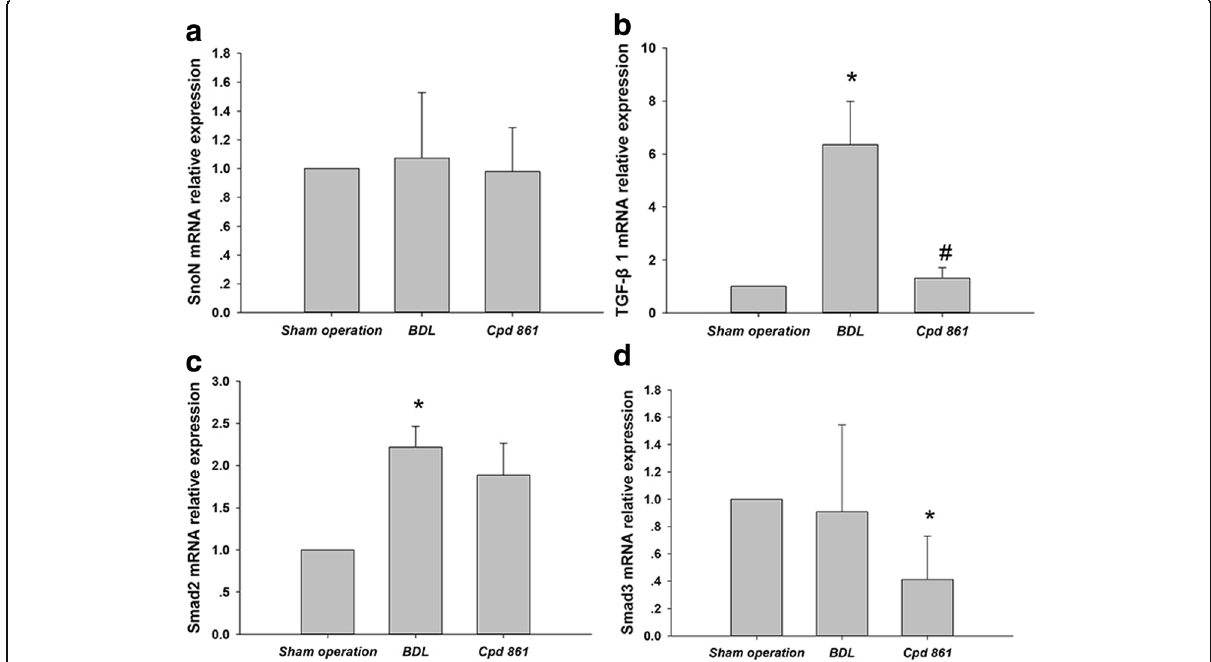
Fig. 3 Effect of Cpd861 on gene expression of SnoN, TGF- β 1, Smad2, and Smad3 for sham operation, bile duct ligation, and Cpd861 groups, as detected by reverse transcription quantitative polymerase chain reaction. Relative gene expression levels for ( a ) SnoN, ( b ) TGF- β 1, ( c ) Smad2, and ( d ) Smad3. Data are expressed as means ± standard deviations ( n =6). One-way analysis of variance was used for statistical comparisons. * P <0.05 vs sham operation group; # P <0.05 vs BDL